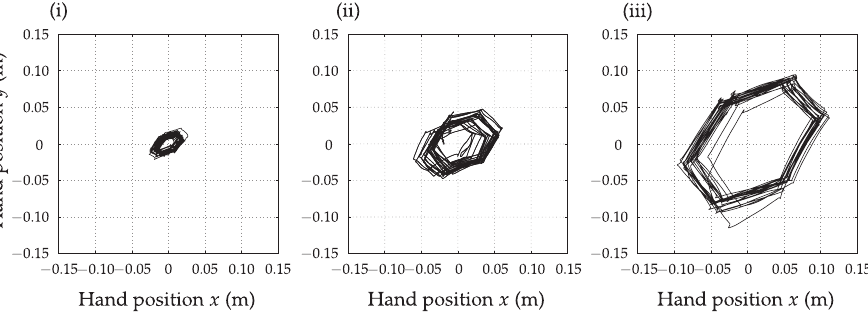
Figure 3. The traversed path of the hand during the sequential drawing of the circumference of a regular hexagon with the length of the base side ( i ) 20 mm, ( ii ) 50 mm, and ( iii ) 100